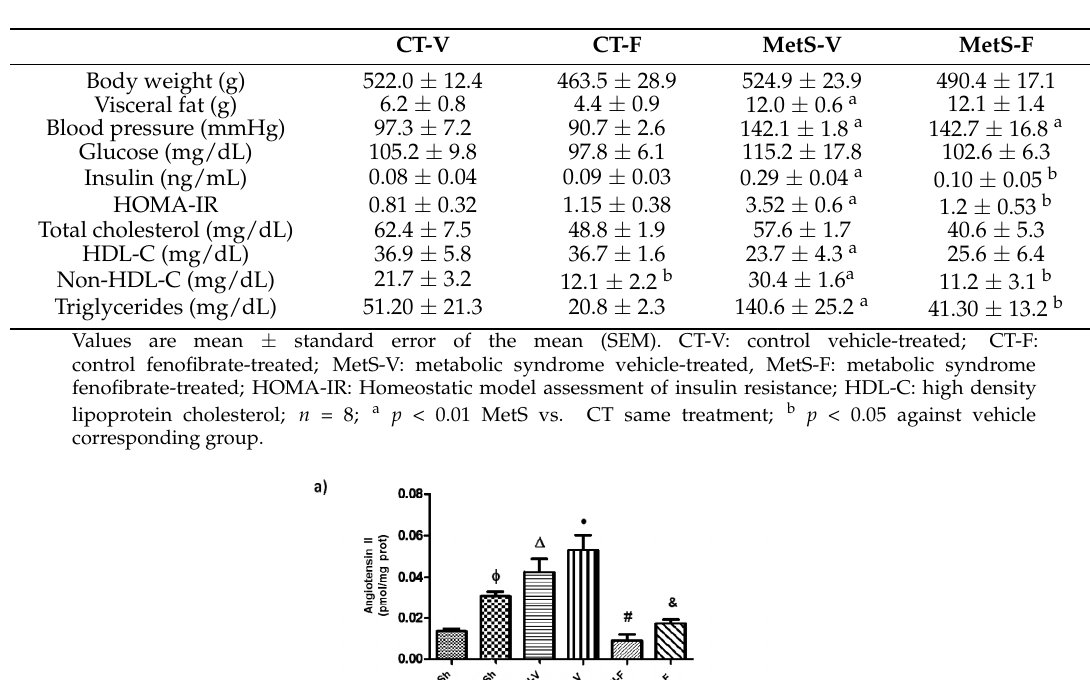
Table 1. Effects of fenofibrate on body characteristics and baseline fasting biochemical parameters from control (CT) and metabolic syndrome (MetS) rats.